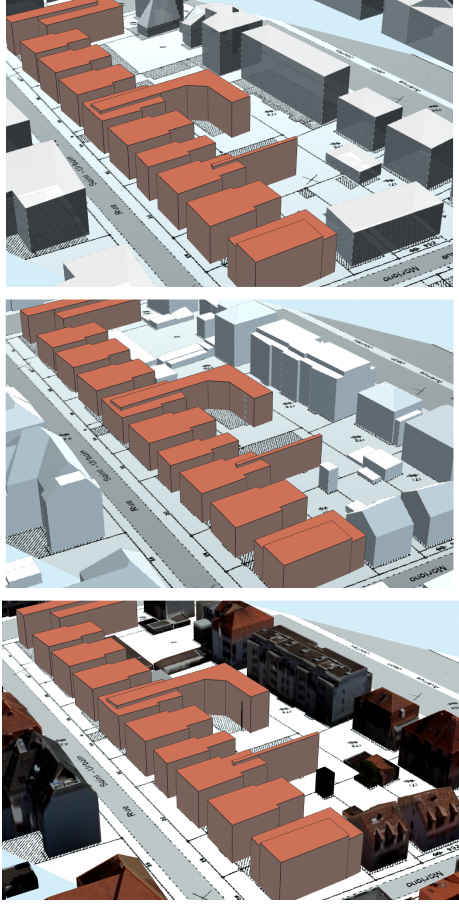
Figure 7. Progressive generalization of the context, with a typi- cal focus: upper image: discreet buildings (generalized blocks); middle image: discreet buildings (preserved building shapes) ; lower image: photo-realist